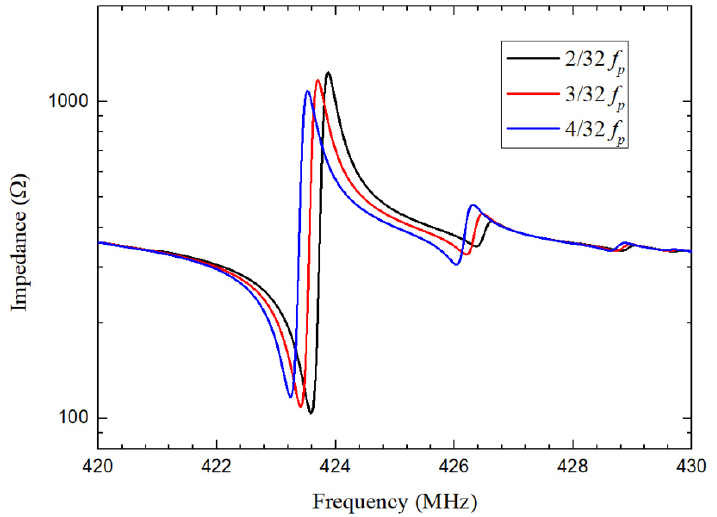
Figure 2. Simulated impedance curves of QSAW resonator with λ of 10.4 µ m for different spaces of 2 λ /32, 3 λ /32 and 4 λ